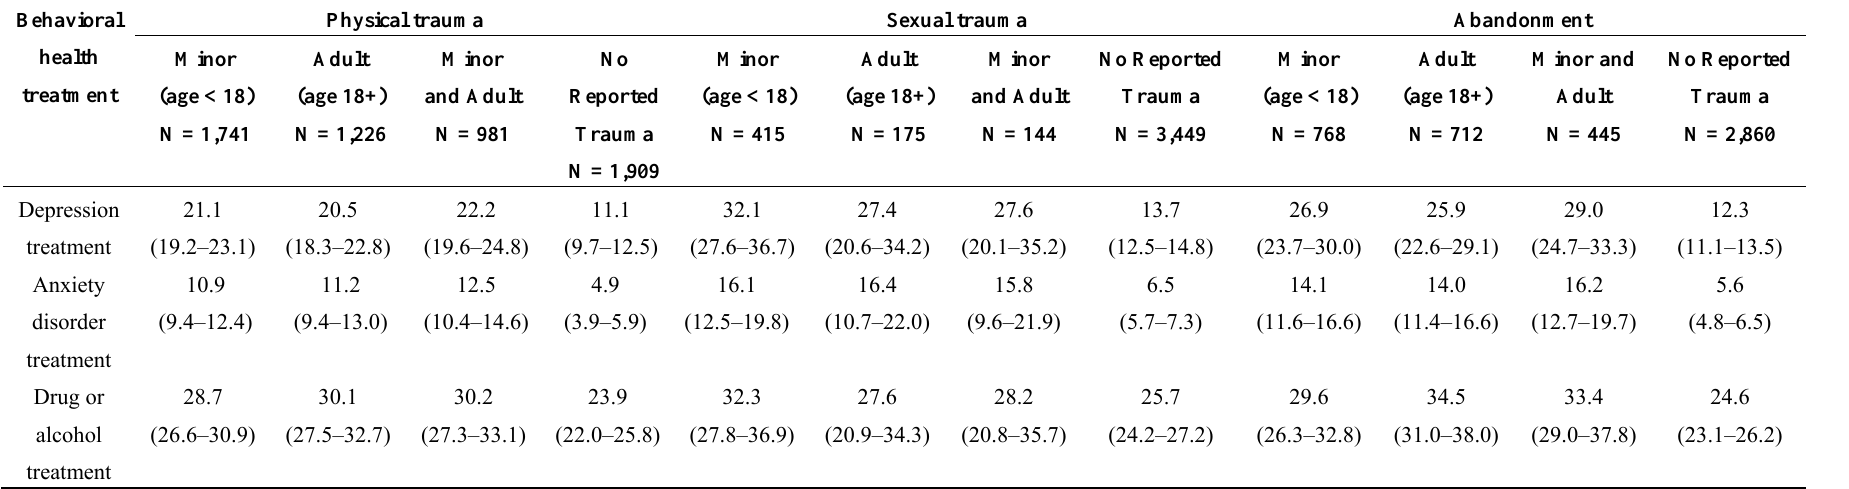
Table 2. Prevalence estimates of behavioral health treatment by type of trauma and age at time of